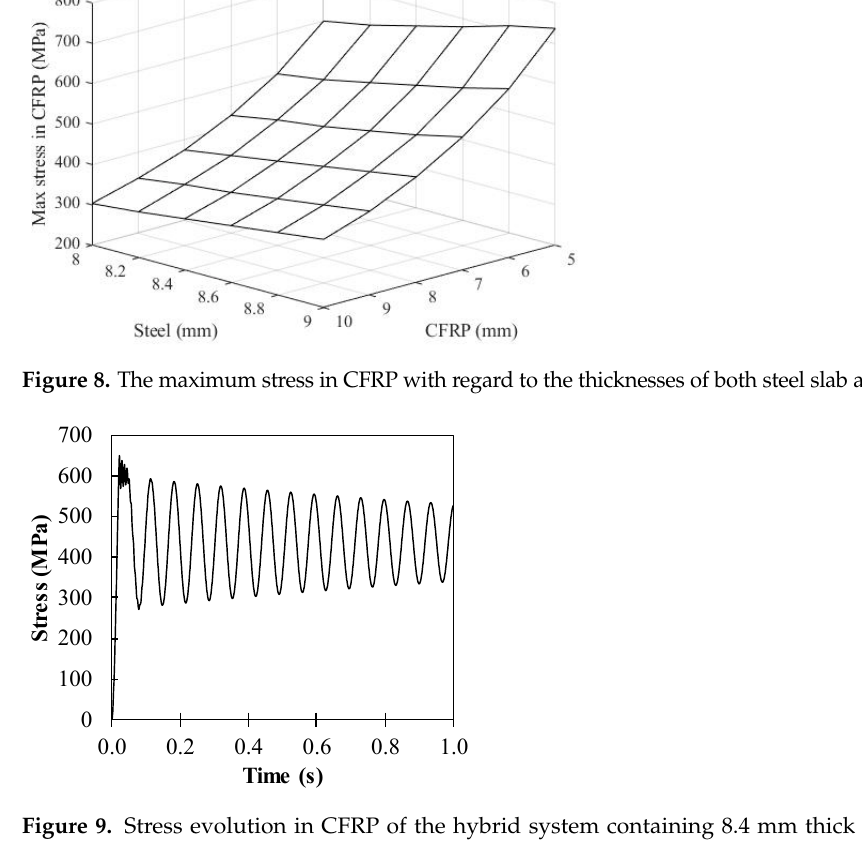
Figure 10. Reliability index of CFRP frame.